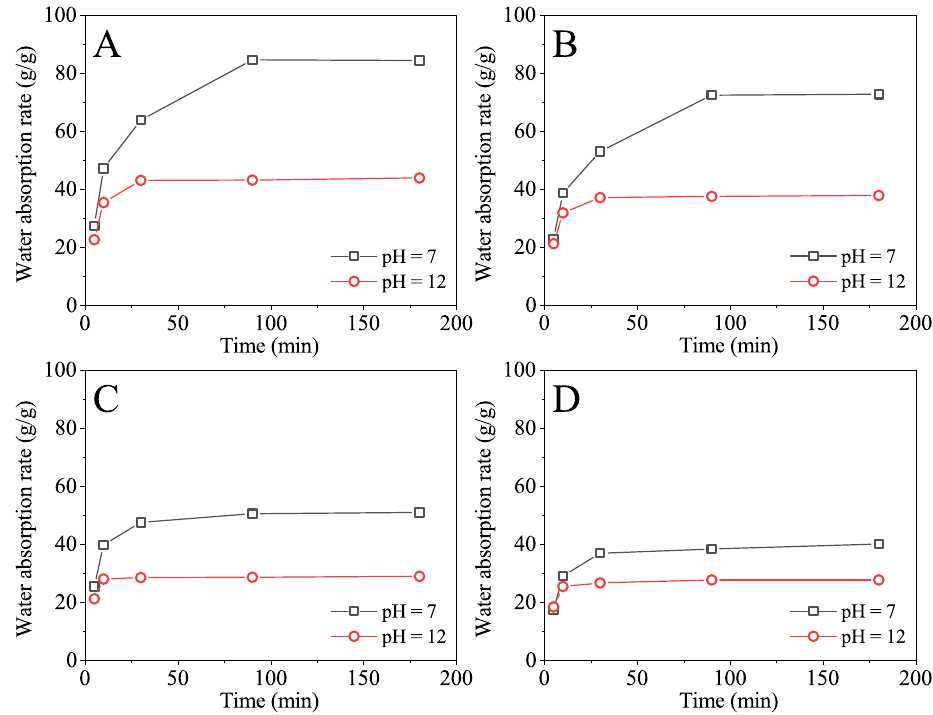
Figure 3. The absorption rates of SAPs prepared with different monomer concentrations tested at 90 ◦ C in water (pH = 7) and in NaOH solution (pH = 12) varied with time; the monomer concentrations are ( A ) 21.00%, ( B ) 26.25%, ( C ) 35.00%, and ( D )